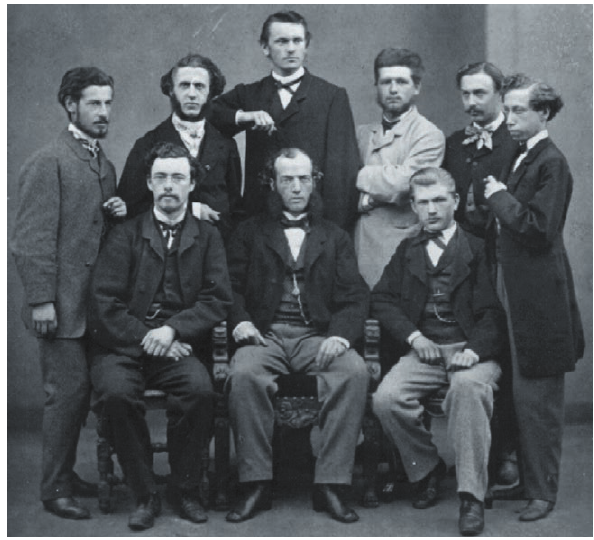
Figure 1. Ladenburg with August Kekulé and the group of his assis- tants and students at the Ghent University (Public domain, from reference